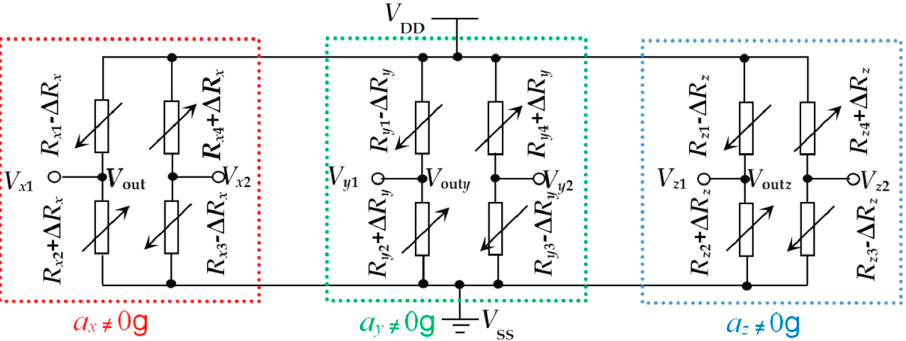
Figure 2. The equivalent circuit of the three-axis accelerometer under the action of a x , a y and a z . When applying acceleration to the chip, the deformations of the proposed accelerometer beams would cause the variations of piezoresistors, where ∆ R x , ∆ R y , ∆ R z are the changes of piezoresistors under the actions of a x , a y and a z , respectively.